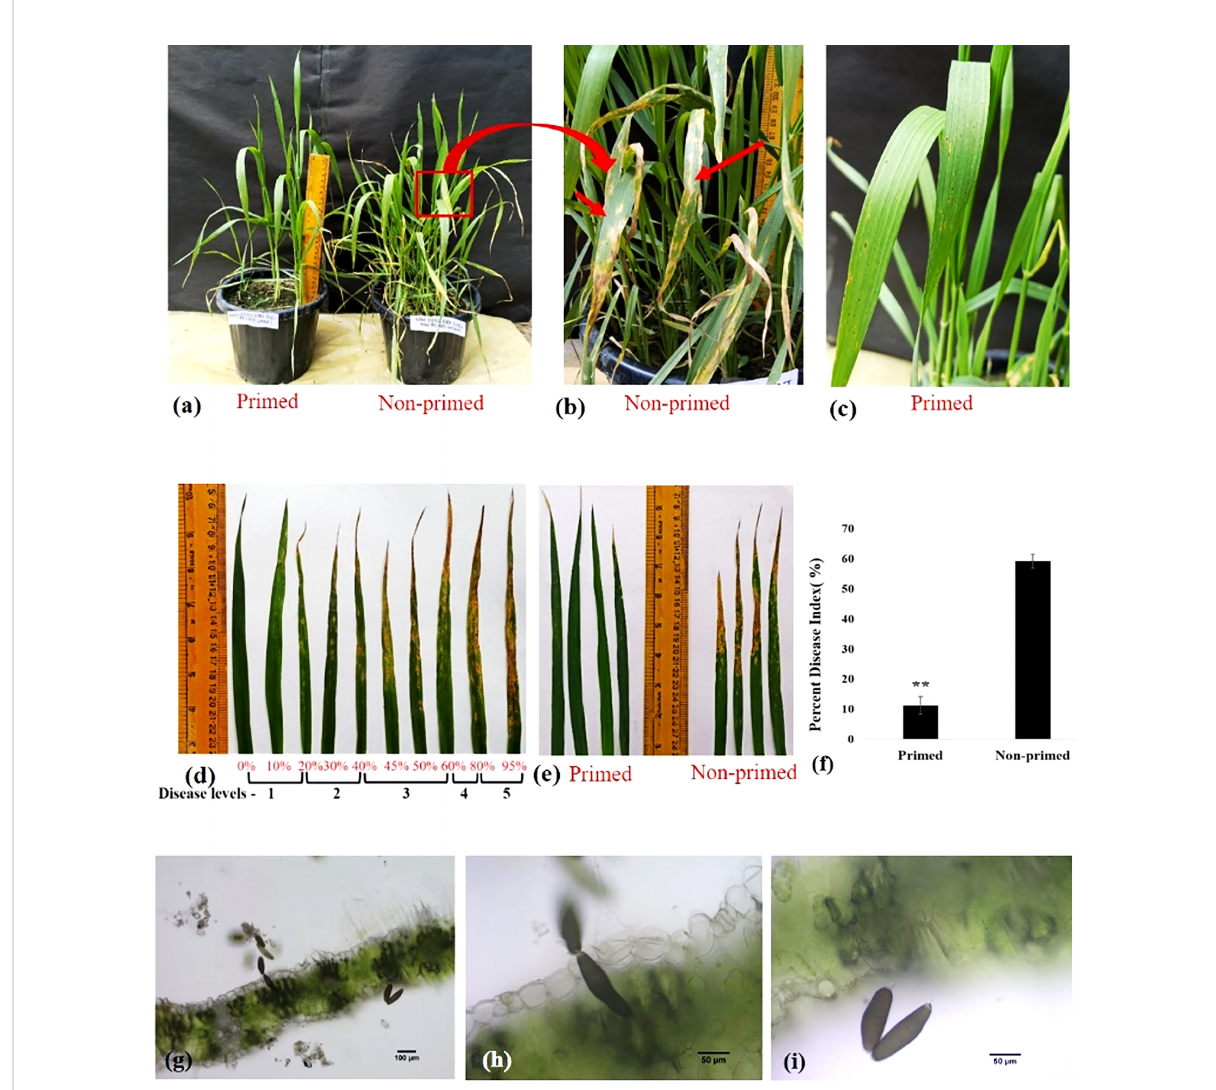
FIGURE 3 Disease assessment of spot blotch disease in wheat in G0 generation. (A – C, E) Symptoms of spot blotch disease on primed and non-primed wheat leaf after challenging with Bipolaris sorokiniana HD 3069. In fi gure b red arrow indicate symptoms of spot blotch. (D) Standard area diagram (SAD) of spot blotch disease in wheat after challenging with Bipolaris . (F) Percent disease index of primed and non-primed wheat after challenging with Bipolaris . (G – I) Conidia of Bipolaris on the wheat leaves 7 dpi under microscope in 10x (G) and 40x (H, I) . Results are representatives of three independent biological replicates. **P<